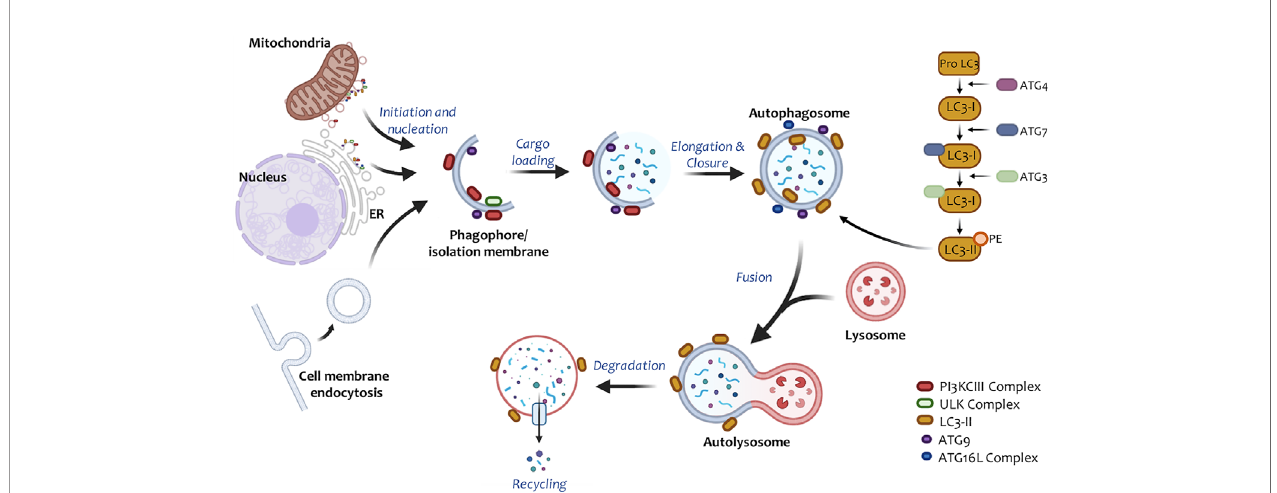
FIGURE 1 | Steps involved in autophagic responses. Autophagy begins with the progressive segregation of cytoplasmic material by double-membrane structures, commonly known as phagophores or isolation membranes. In general, this process is preceded by the inactivation of the PI3K/Akt/mTOR signaling axis. Phagophores are nucleated primarily from the endoplasmic reticulum (ER), but other organelles, such as the Golgi apparatus, plasma membrane, mitochondria, and recycling endosomes have also been shown to participate in this process. The complexes ULK1 and PI3KCIII are involved during phagophore initiation and elongation. Pro-LC3 is free in the cytoplasm and by the action of ATG4 and ATG7, LC3-I is formed. This molecule interacts with the complex ATG16L, ATG3, to later incorporate a phosphatidylethanolamine (PE) molecule into its structure. This results in LC3-II, which binds to autophagosomal membranes and contributes to phagophore elongation as well as closure. Then, these membranous structures seal, and autophagosomes are entirely assembled. Subsequently, autophagosomes fuse with lysosomes to form single membrane structures called autolysosomes, where the degradative process takes place through lysosomal hydrolases. The degradation products of these catabolic reactions reach the cytosol through transporters in the lysosomal membrane and are recycled by bioenergetic